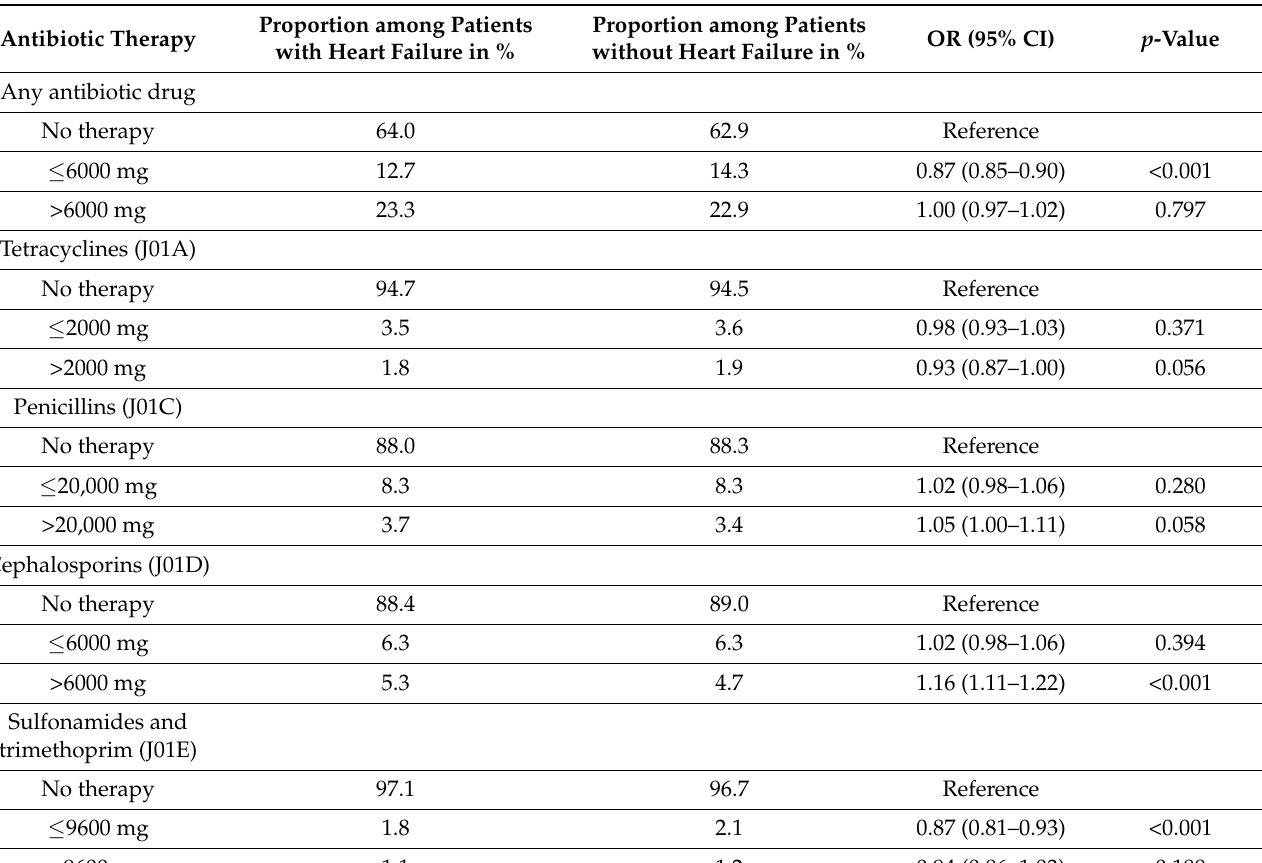
Table 2. Association between antibiotic therapy and heart failure (multivariable logistic regres- sion